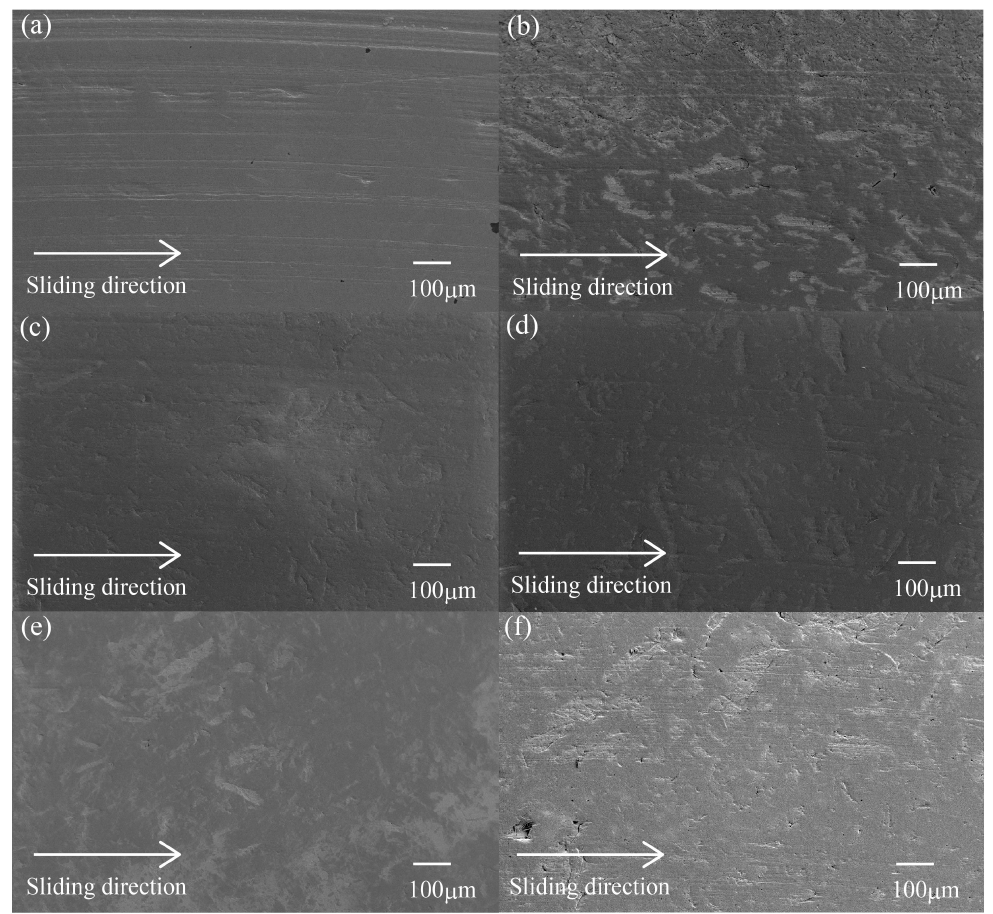
Figure 7. SEM photographs of the worn surface after sliding wear tests of various surface-treated HF/PA1010 biomass composites: ( a ) PA1010; ( b ) HF; ( c ) HF-S1; ( d ) HF-S2; ( e ) HF-S3-20 and ( f ) HF-S3-30. Materials 2017 , 10 , 1040